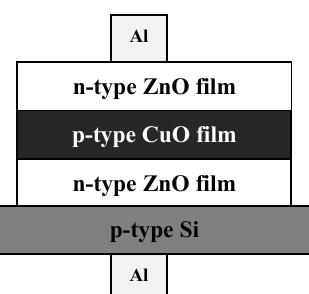
Fig.1: Schematic diagram of the ZnO-CuO-ZnO/Si heterojunction